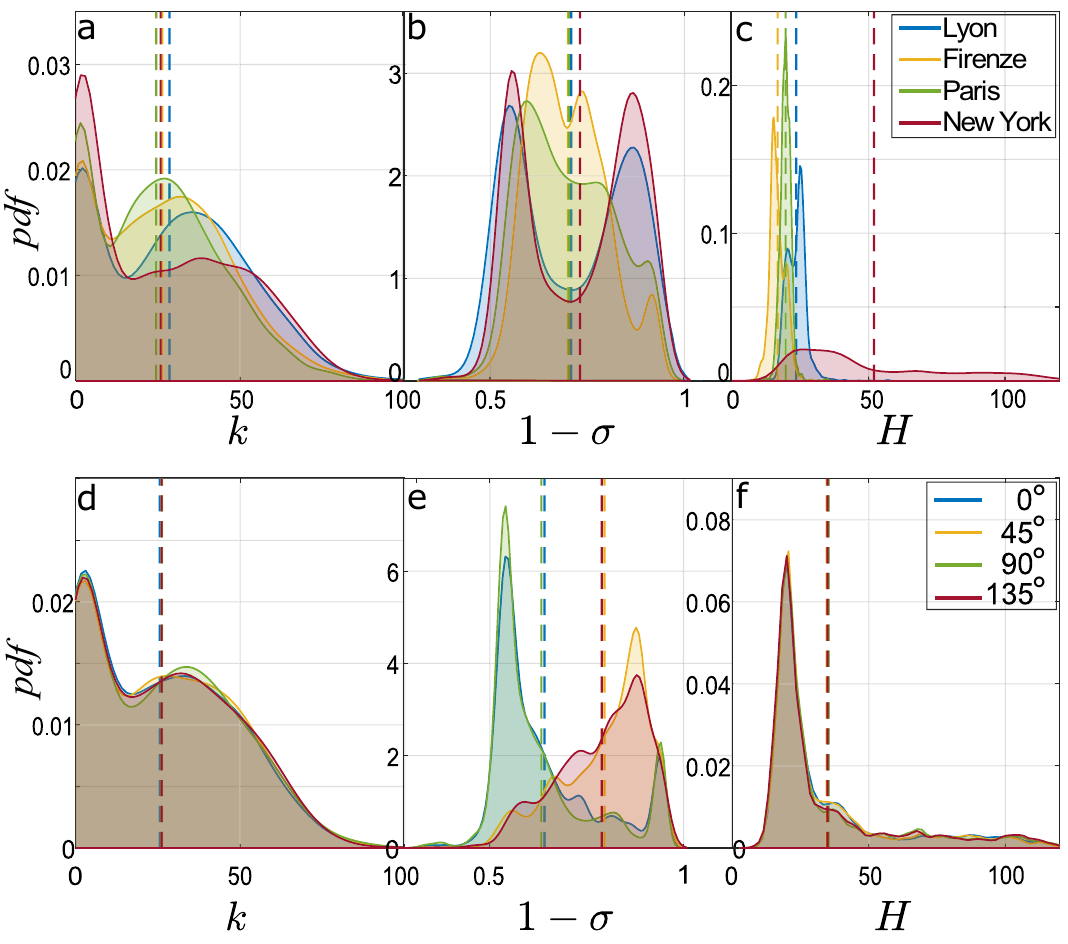
Figure 5. Probability density function of the key parameters k , 1 − σ , H . In the first row, each curve refers to a city and includes vulnerability data from eight different wind directions. In the second row, each curve corresponds to a specific wind direction and includes vulnerability data from the four cities, together.